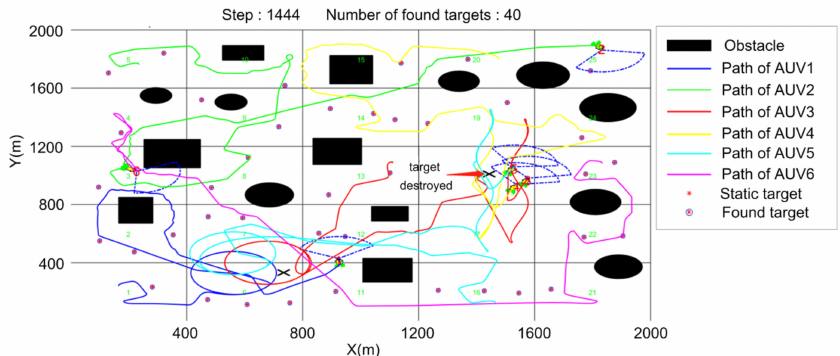
Figure 24. Final experimental